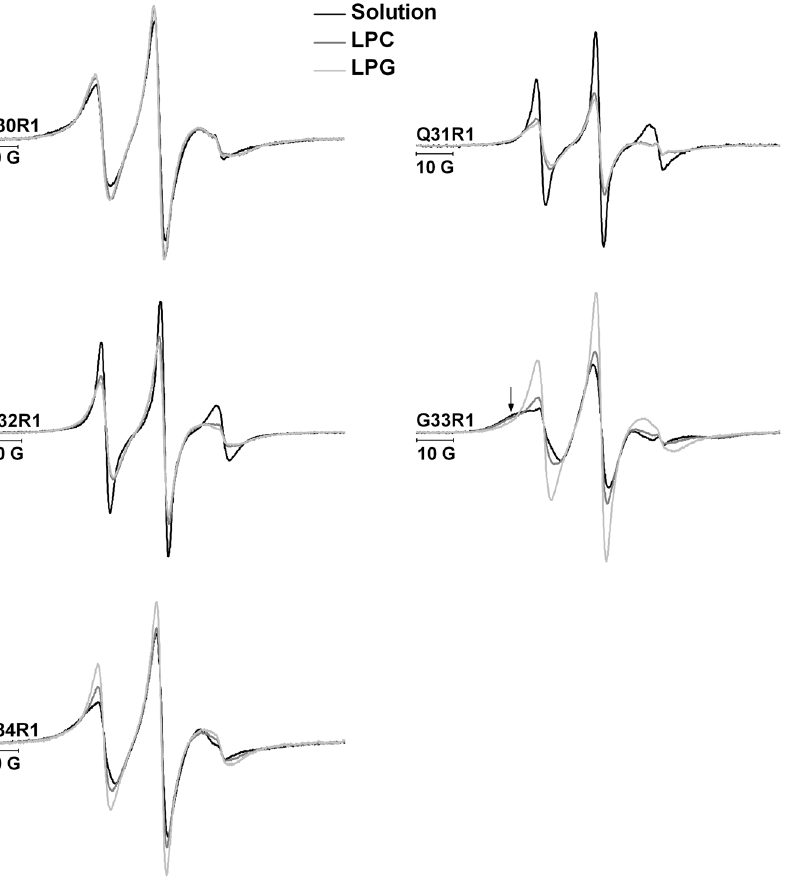
Figure 4. ESR spectra of B-FABP mutants R30R1, Q31R1, V32R1, G33R1 and N34R1 in the absence (black) and in the presence of LPC (gray) or LPG (light gray) micelles in 20 mM phosphate buffer (pH 8.0). The arrow denotes the more immobilized population in the G33R1 spectrum.